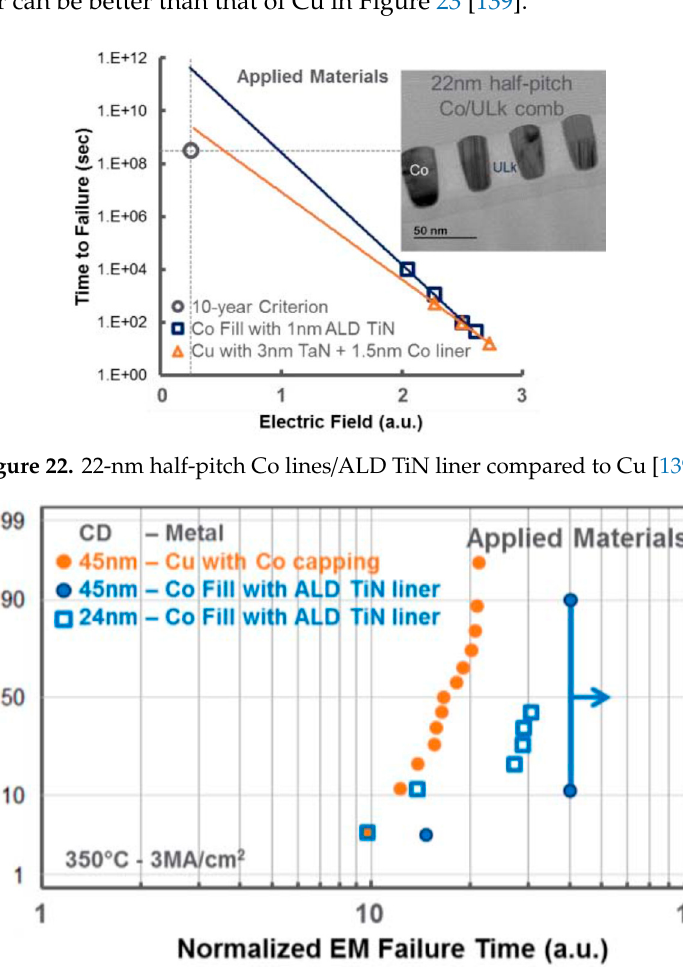
Figure 24. EM lifetime distributions for the Co and Cu alloy [157]. Chemical vapor deposited tungsten (CVD W) based middle-of-the-line (MOL) contacts and local interconnects have been extensively used in high-performance CMOS logic IC’s. The standard process scheme has included a TiN adhesion layer to dielectrics and a nucleation W layer for CVD W, but these layers consume most of the volume in narrow features. A major challenge for W fill scaling is that the line resistance of sheet Rs and plug resistance of contact Rc increase due to a reduction in the volume of the low resistance CVD W bulk material. Recent simulation results of the local interconnect resistance indicated that the M0 and the contact would become dominant contributors to a resistance increase at the 5-nm process node [155]. W M0 and Contact comprise 65%